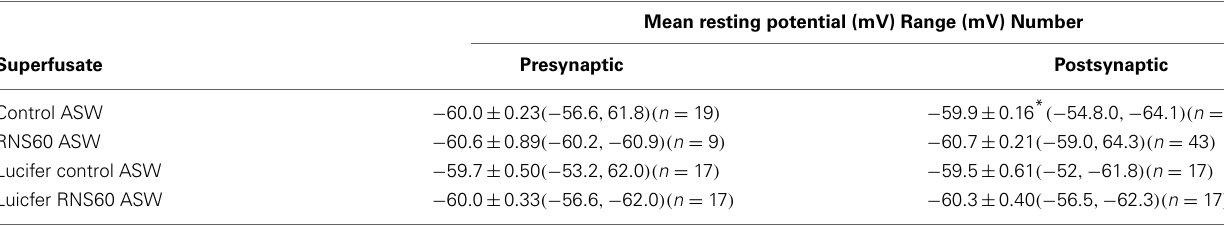
Table 3 | Range and mean presynaptic and postsynatpic membrane resting potential in control ASW and